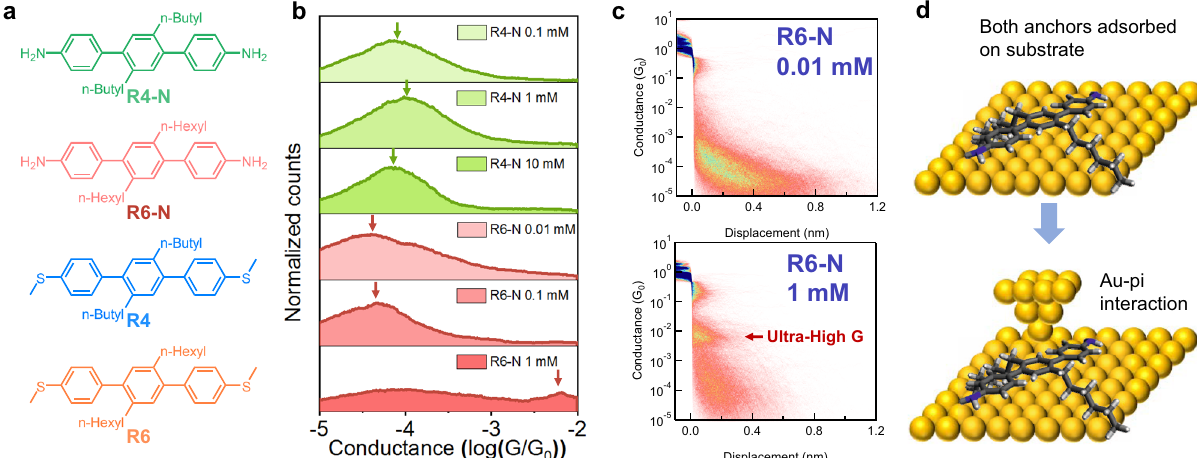
Fig. 4 Effect of alkyl side chains in amine-terminated terphenyl derivatives. a Chemical structures of R4-N, R6-N, R4, and R6. b Concentration- dependent study of R4-N and R6-N. c 2D conductance histograms of 0.01 mM (low G state) and 1 mM (ultra-high G state) R5. d Hexyl side chains in R6-N facilitate backbone adsorption and planarization. However, the gold tip cannot pick up from the amine end, which induces Au – pi interaction and exhibit ultra-high